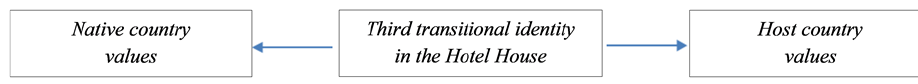
Figure 2. Third transitional identity in Hotel House.